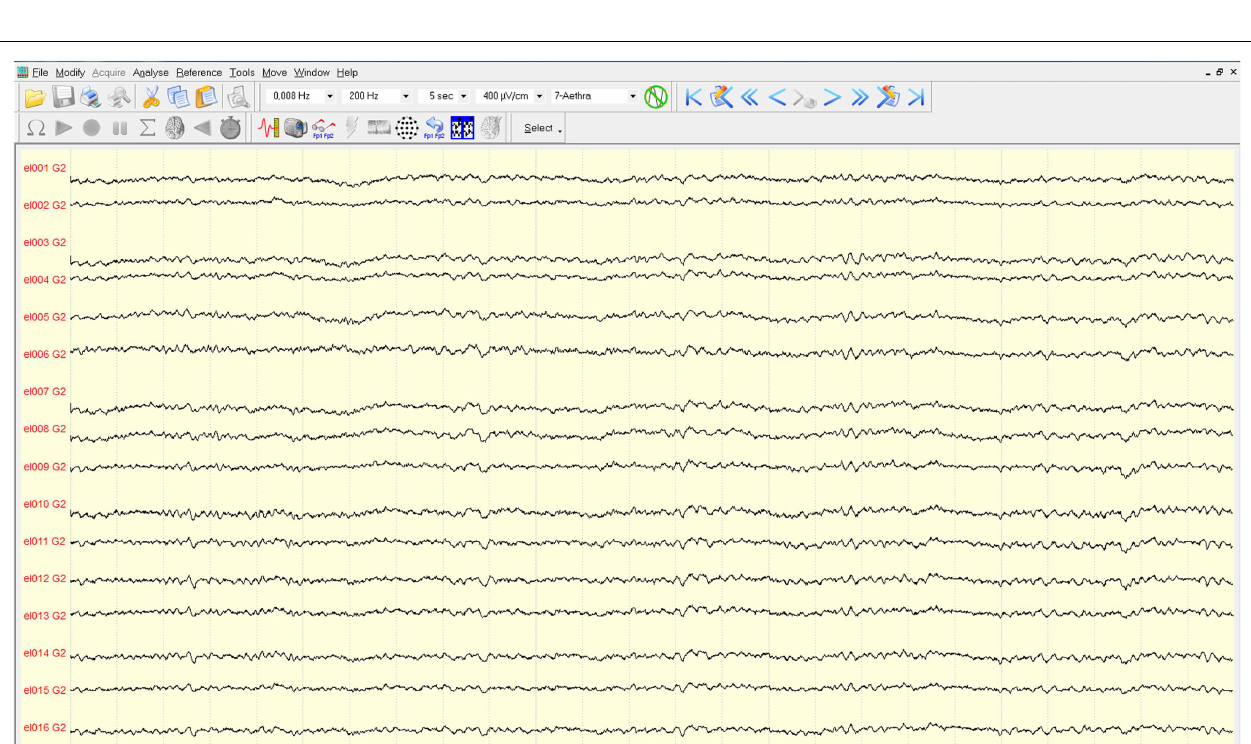
FIGURE 4 |Traces of the EcoG . Signals are filtered with a pass-band filter from 0.008 to 200Hz.The time interval between two vertical gray lines is